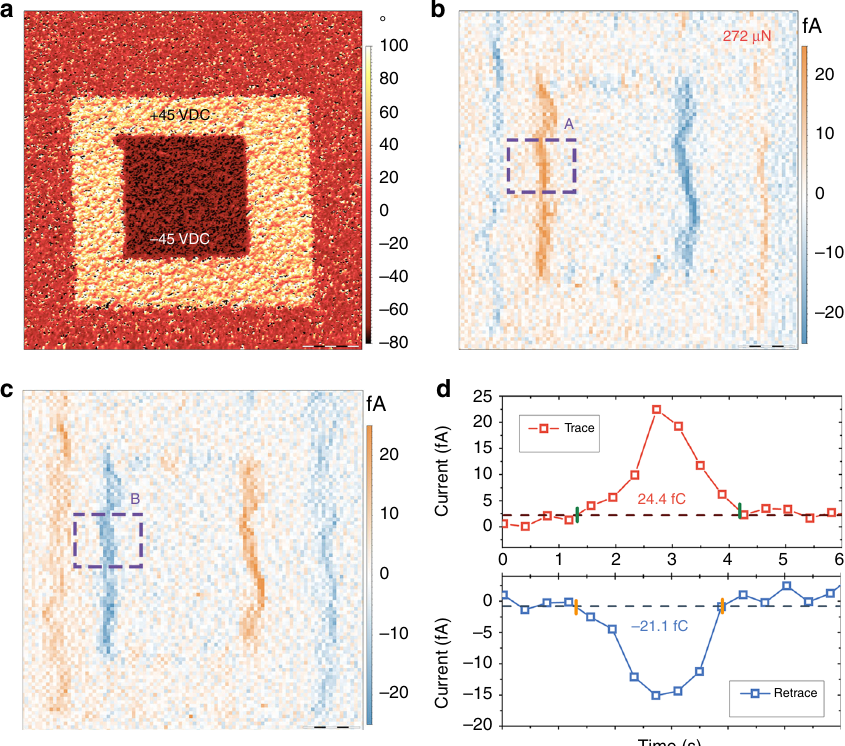
Fig. 5 Piezogenerated charge of bismuth ferrite (BFO) a PFM phase image of a 400 nm thick BiFeO 3 (BFO) ferroelectric fi lm in which two zones of opposite polarization were previously recorded. b DPFM-Si image and c DPFM-So image of the prerecorded areas, scale bar 2.5 μ m. The inner, smallest square presents the largest current output, as we are crossing between two domains fully polarized in opposite directions. Accordingly, when crossing the large outer square border a lower current is recorded, as we are crossing from a virgin state to a fully polarized domain. d Mean-pro fi le of the dot-line squared area A- in b- top and Mean pro fi le of the dot-line square B of c. Both pro fi les where directly integrated to obtain the piezogenerated